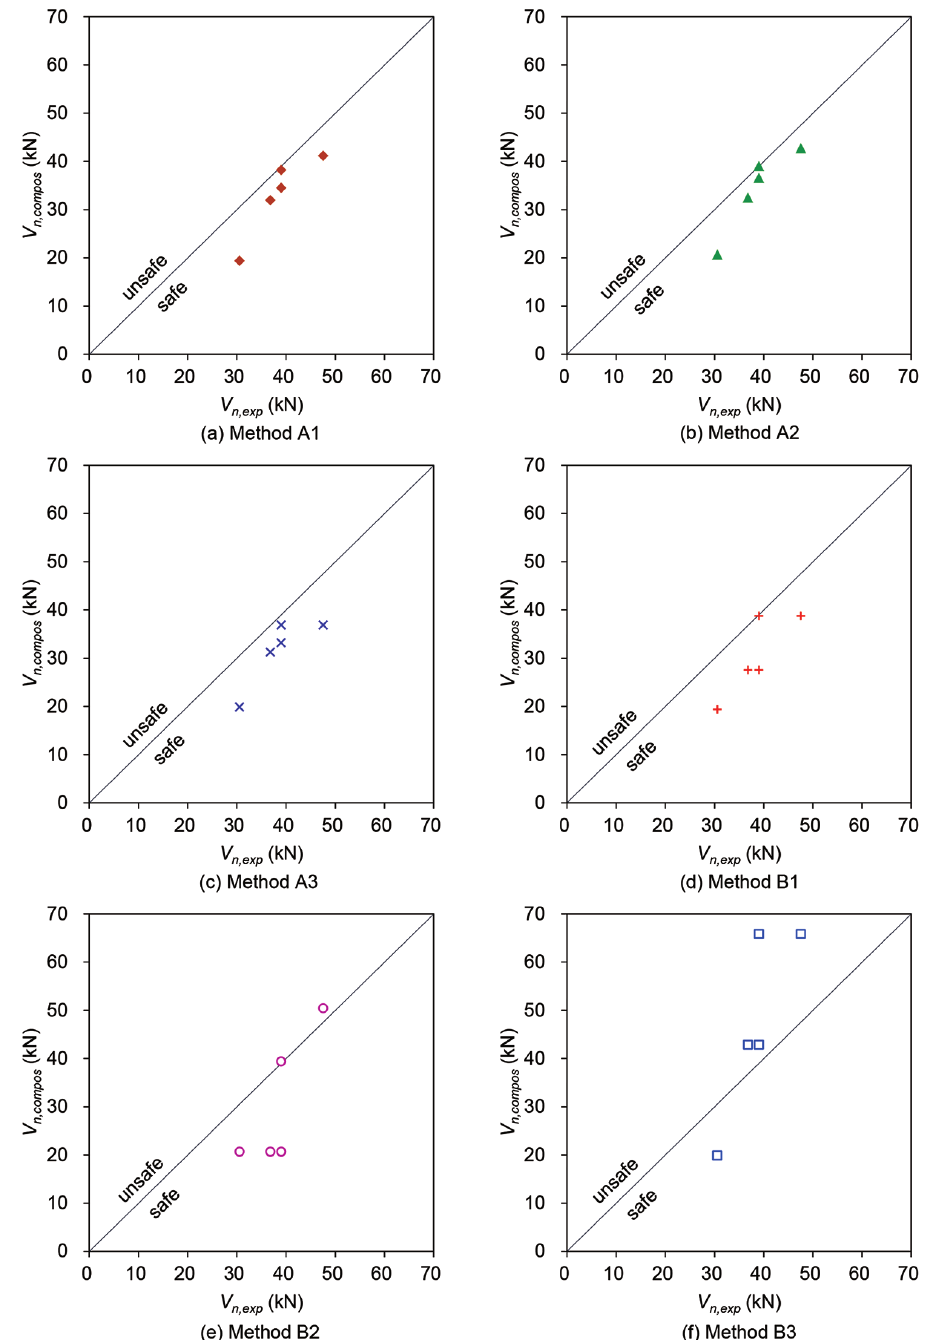
Figure 4. Predicted shear forces plotted against experimental results for OV series specimens (including